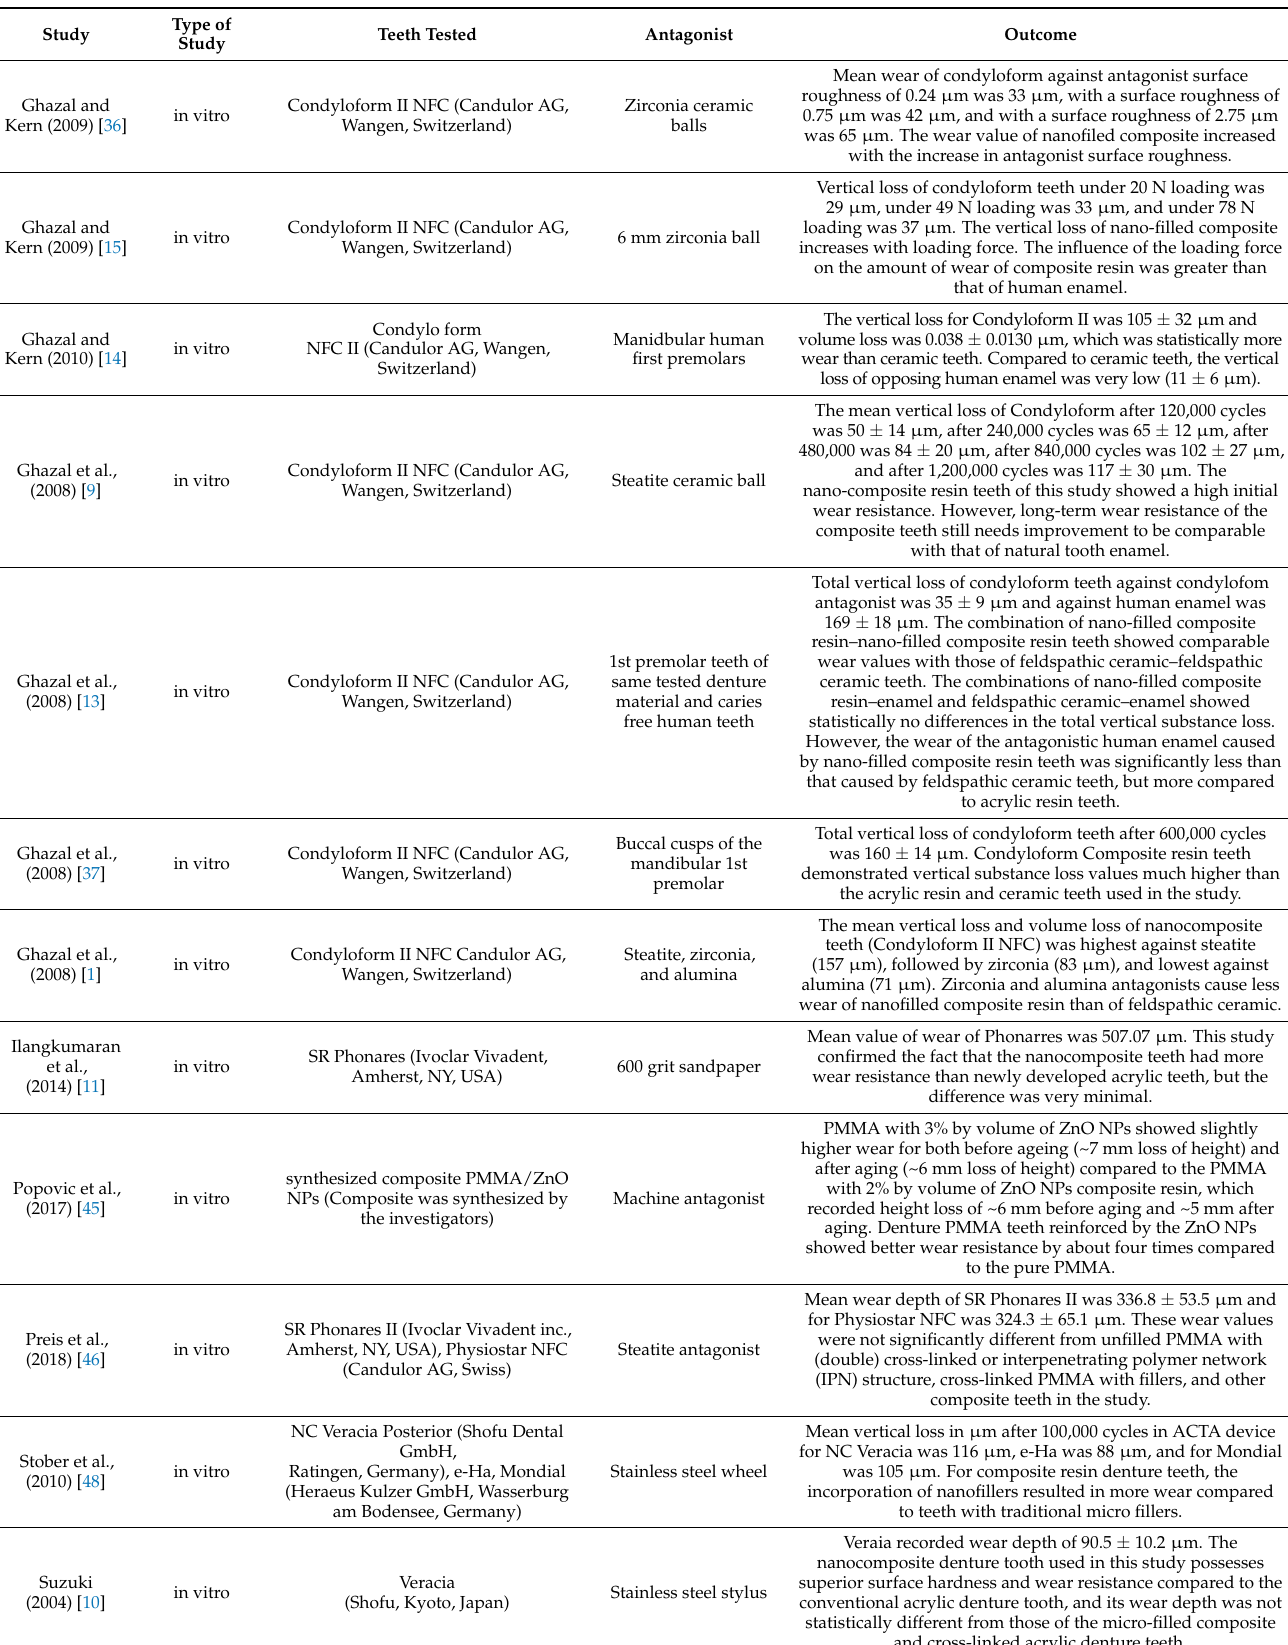
Table 6. Main findings of the selected studies on denture teeth wear